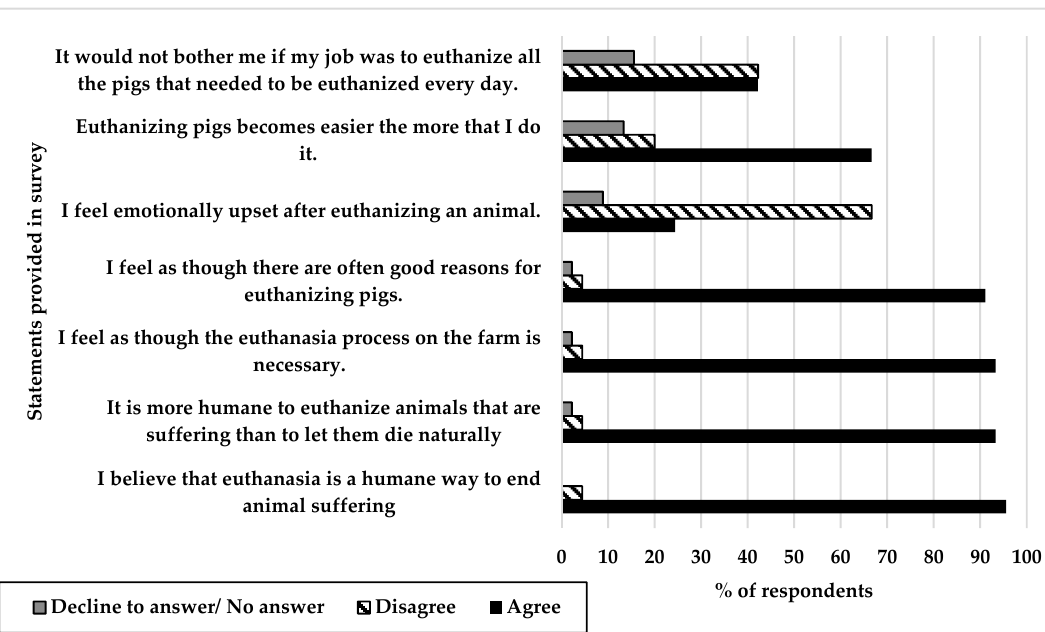
Figure 1. The level of agreement by respondents ( n = 45) with various statements regarding perceptions of euthanasia. For each statement, respondents were given the following options: strongly agree, agree, disagree, strongly disagree, and decline to answer. In this figure, “Agree” represents agree and strongly agree responses and “Disagree” represents disagree and strongly disagree responses. “Decline to answer” also includes respondents that provided no selection.